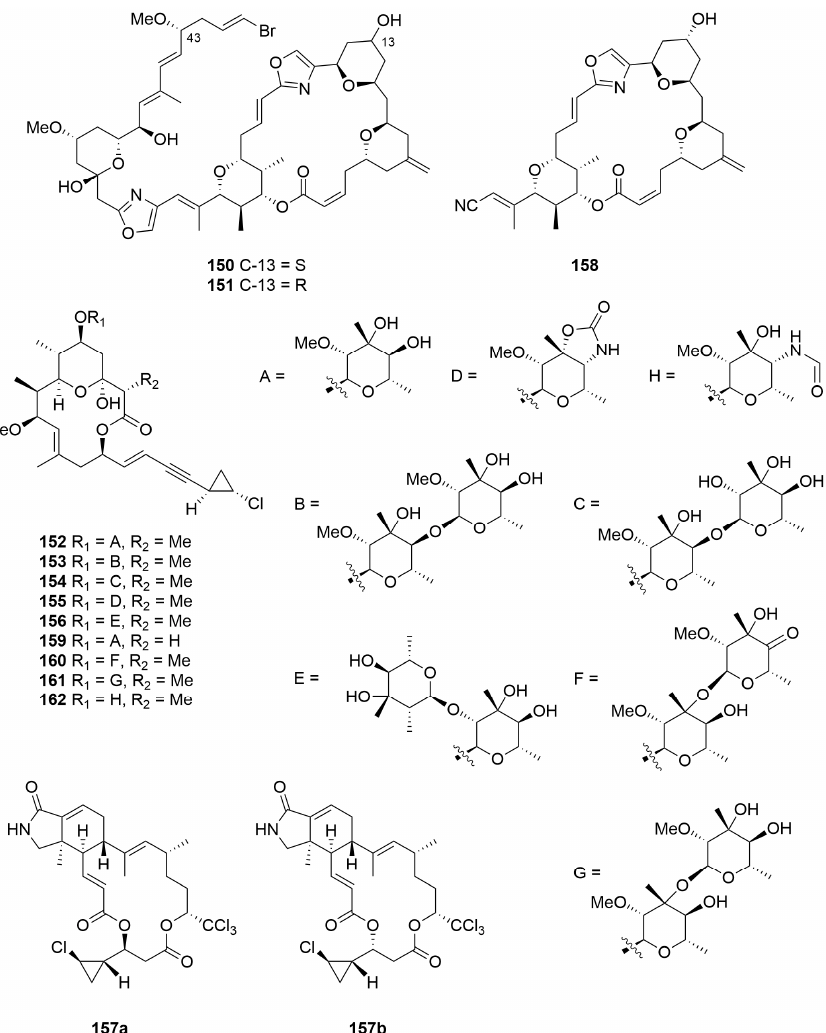
Figure 9. Compounds 150 to 162